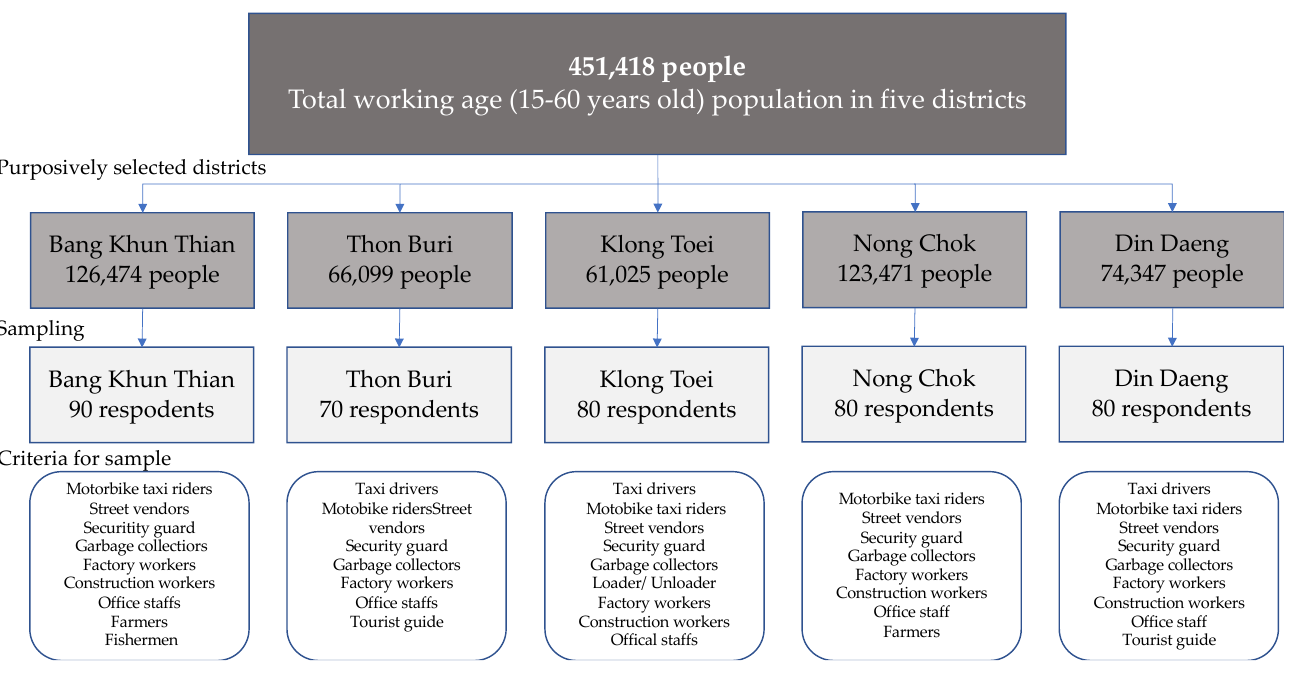
Figure 2. Sample procedure of the study.